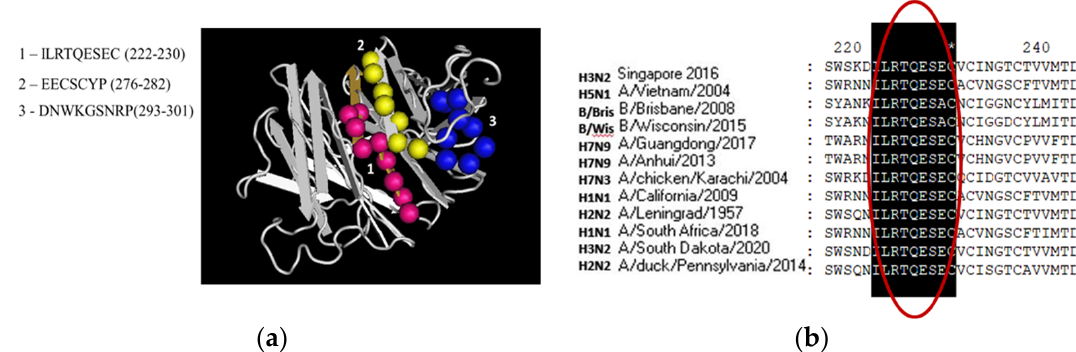
Figure 1. Molecular structure of NA insertion. ( a ) Three-dimensional model of the NA insertion (AA 123–331) built on the basis of the NA model of the 1957 pandemic influenza H2N2 virus; ( b ) Multiple alignment of influenza A and B viruses NA.